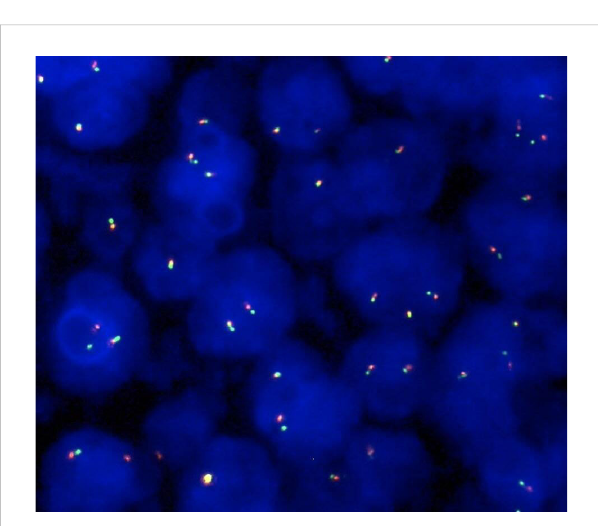
FIGURE 4 Representative example of interphase FISH fi nding using the NTRK2 probe (100x): Lymphoma cells lacking a translocation with two orange/green fusion